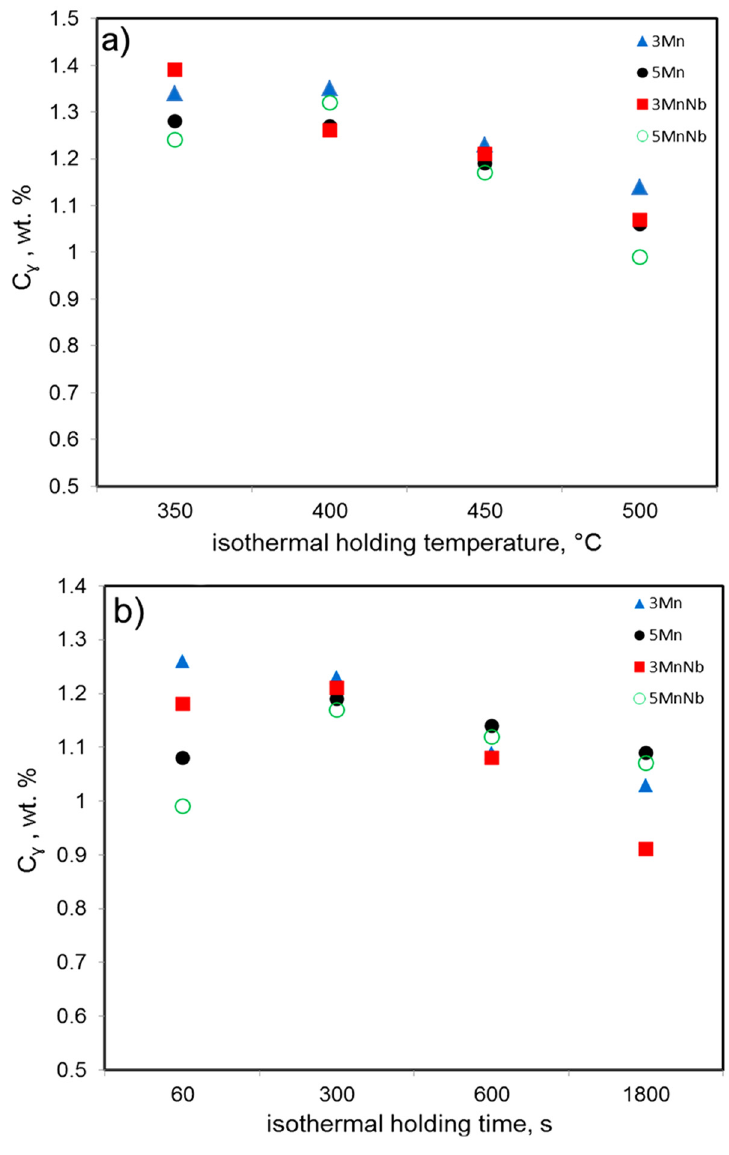
Figure 4. ( a ) Influence of isothermal holding temperature on the carbon content in retained austenite for the steels treated for 300 s; ( b ) Influence of the isothermal holding time at 450 °C on the carbon content in retained austenite.